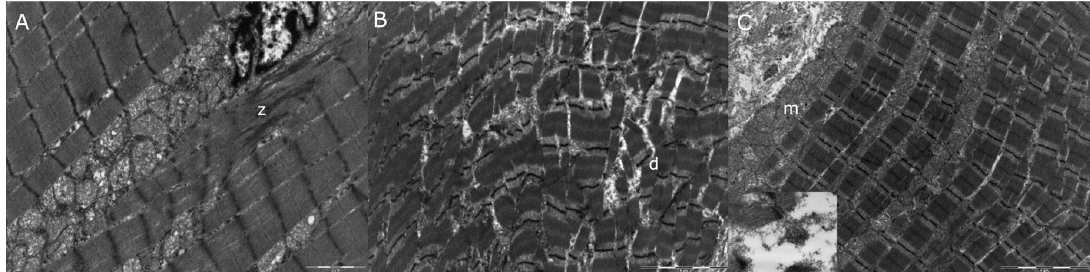
Figure 4. Electron microscopy of diaphragm muscle ( A and B ) and tongue ( C ): mild myopathic changes were seen as Z-line streaming (z), myofibrillar disarray (d), and mitochondrial hyperplasia (m): mitochondria seemed to be increased in size compared to the control (insert). 10500x.